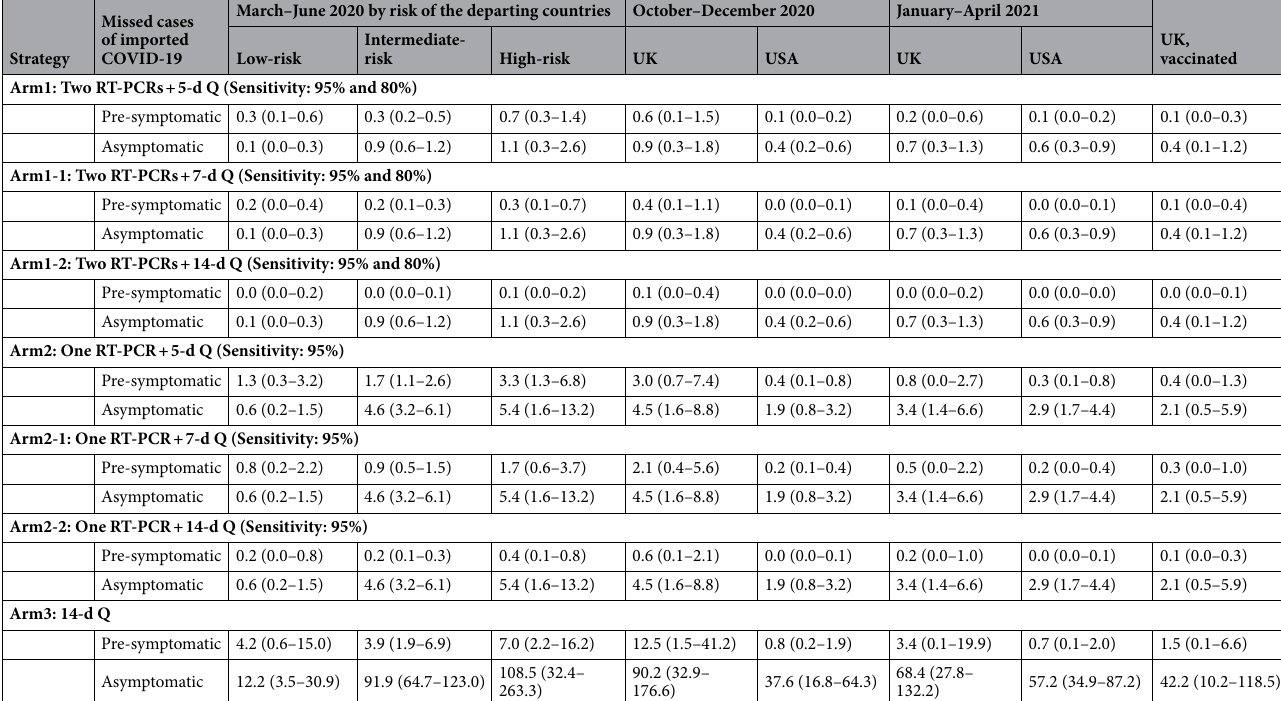
Table 2. Simulated number of missed cases of imported passengers in the randomized controlled design during March and June in Taiwan using Markov Chain Monte Carlo methods x-d Q: x-day quarantine; UK, vaccinated: The vaccine efficacy was applied to the scenario in the UK in October–December